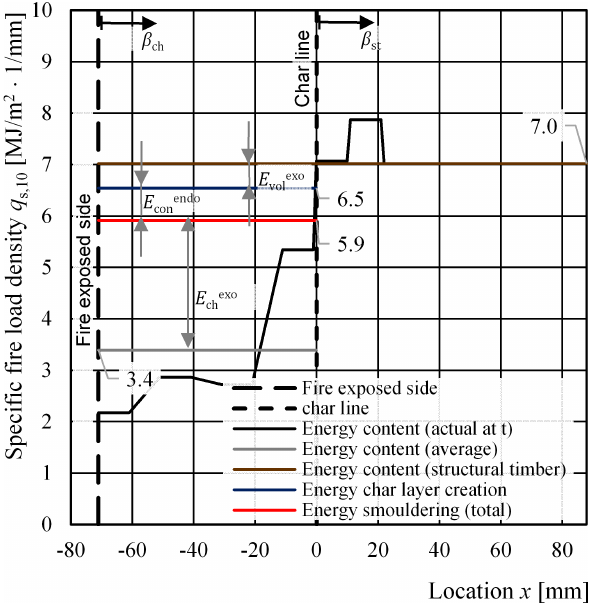
Figure 11: The TiCHS-model for a structural timber section exposed on one